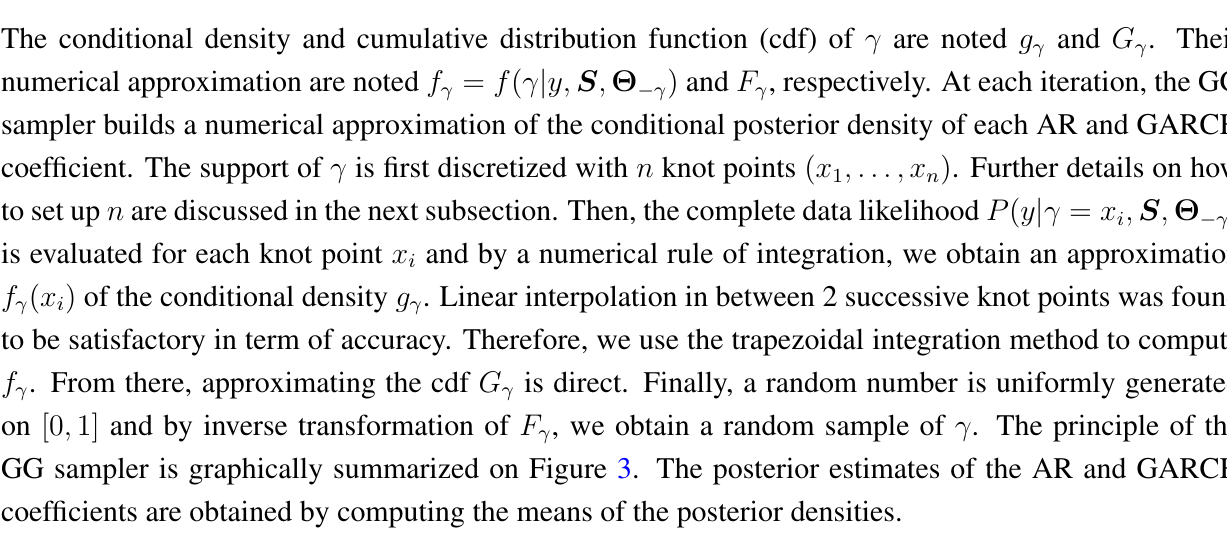
of a given coefficient γ is approximated by numerical γ